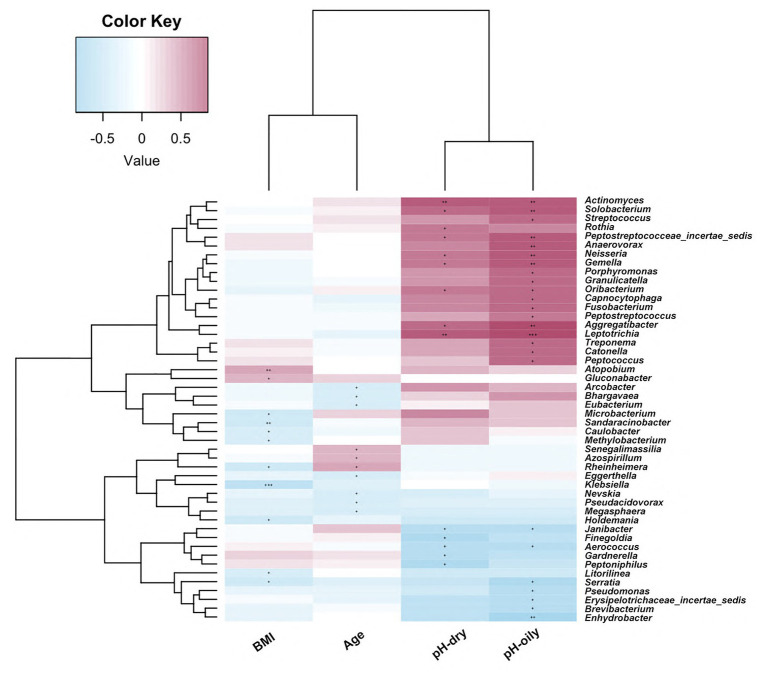
Correlations of facial bacterial microbiome abundance with clinical characteristics. The heat map of Spearman’s rank correlation coefficients between the facial bacterial microbiome abundance and clinical parameters. +p < 0.05; ++p < 0.01; +++p < 0.001; BMI, body mass index.